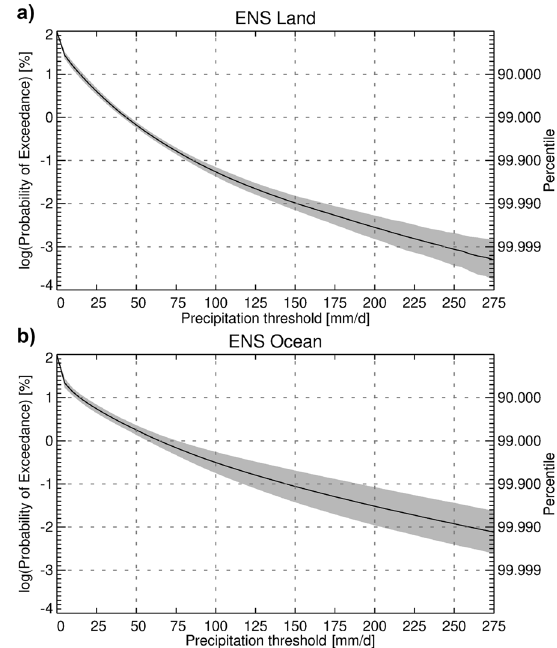
Fig. 1 The probability of exceedance of precipitation threshold shows the rarity of the very intense precipitation conditions. a Over land and b over ocean. The black curve corresponds to the ensemble mean probability in %. The gray shading area corresponds to the spread within the precipitation products ensemble based on one relative standard deviation (see “ Methods ”